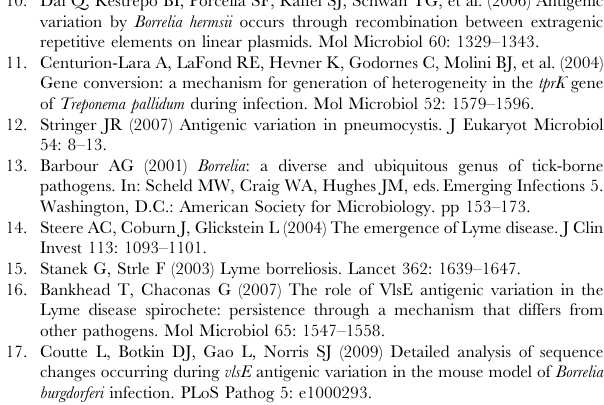
Figure S1 Strategy for the construction of knockout plasmids.